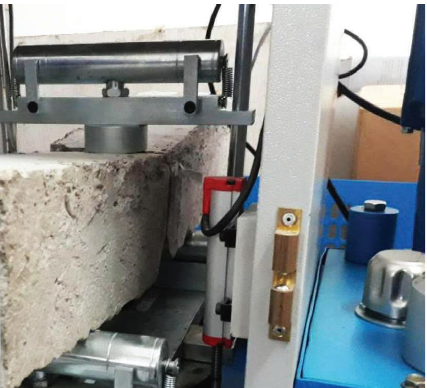
periment. Te samples were placed in the water pool for 28 days. Te samples with dimensions of 10 × 10 cm were placed in front of the rays of the gamma ray source. Tis Figure 3: Flexural strength test.